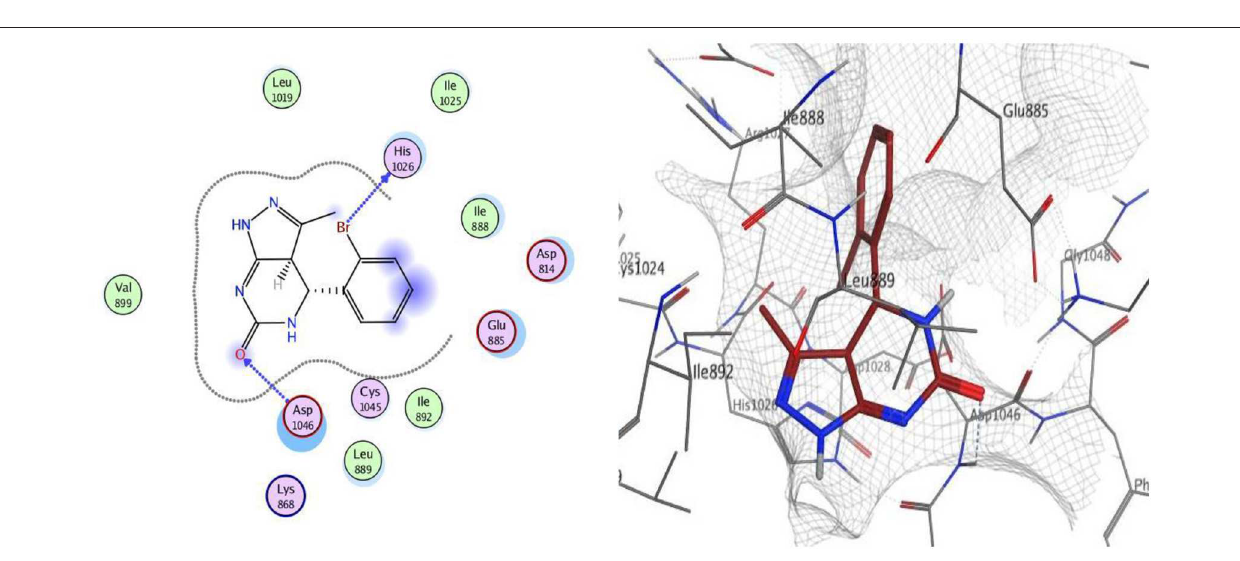
FIGURE 5 | 2D and 3D interaction map of compound 12 within the active site of VEGFR2